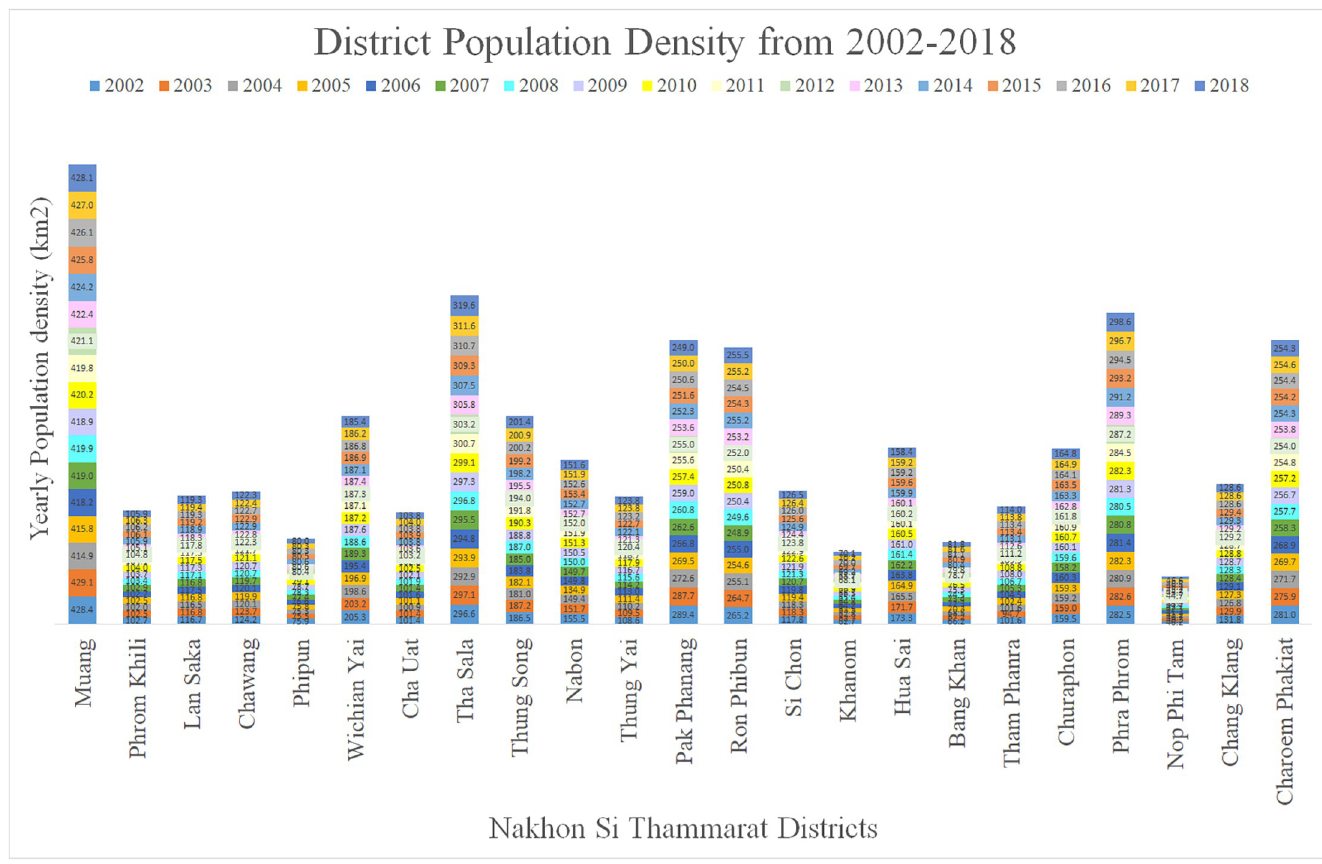
Fig 2. Yearly district population density per square kilometre (PD/km2) in Nakhon Si Thammarat from 2002–2018.